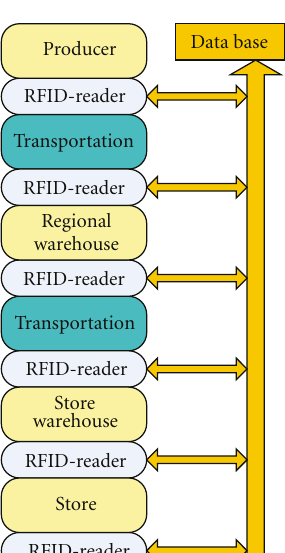
Figure 15: The database connected via the backbone, enabling continuous tracking of